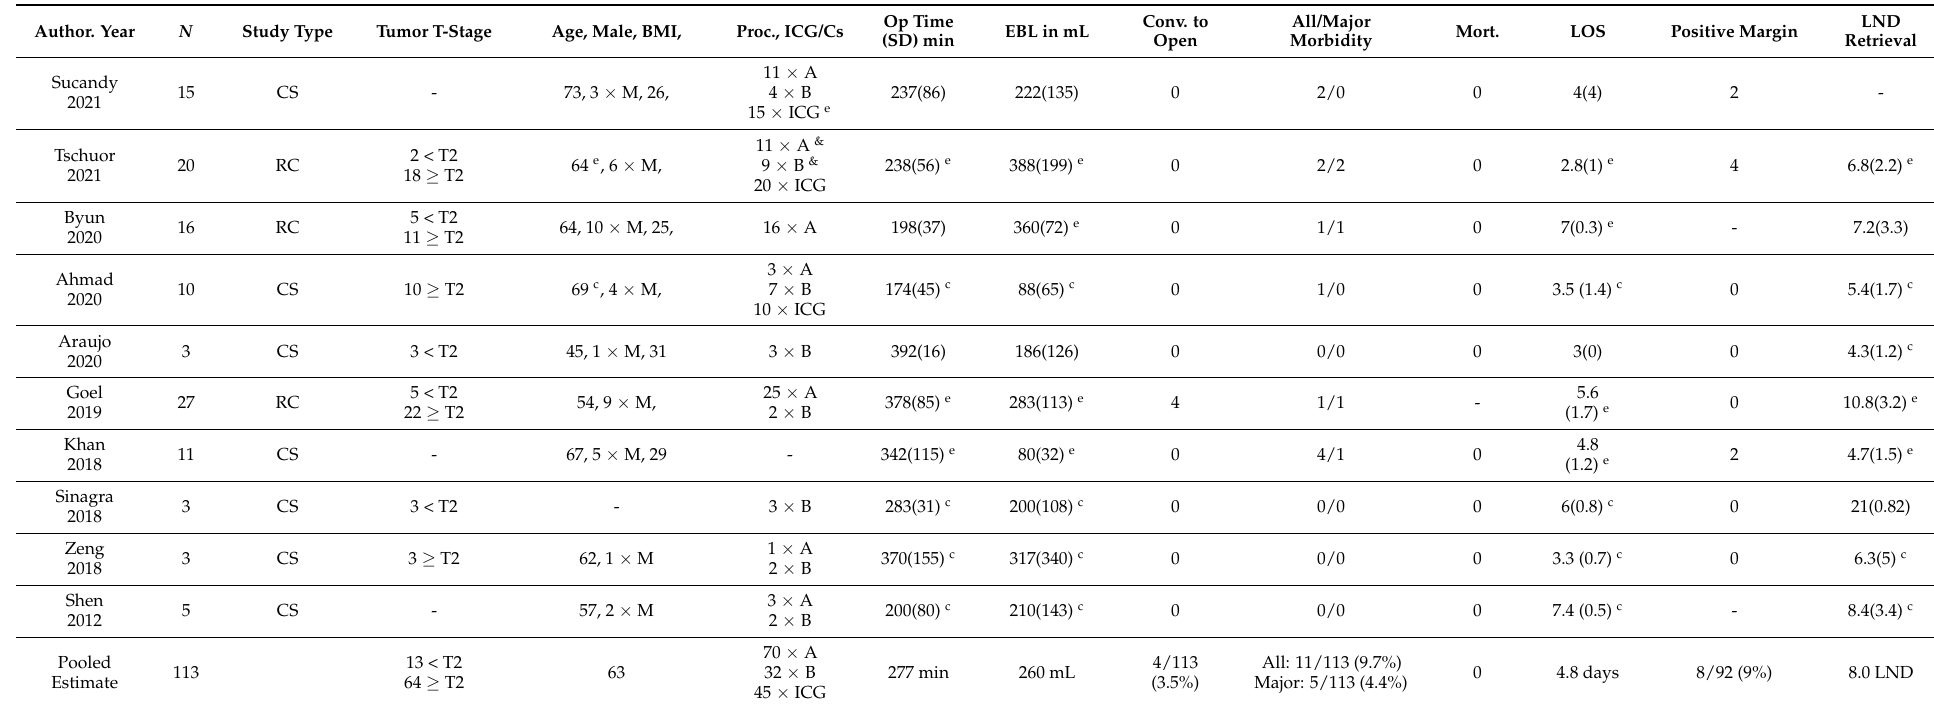
Table 3. Systematic review of robotic gallbladder cancer